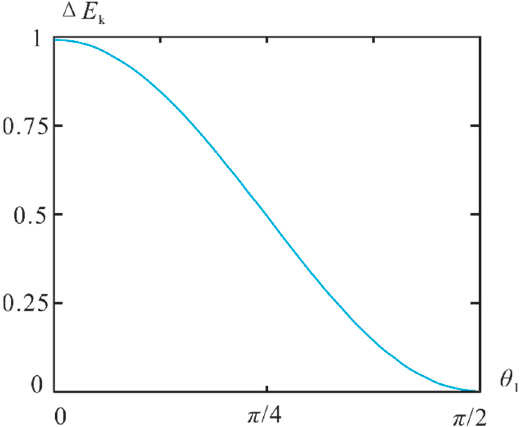
Figure 7. The change of the trunk work with the robot trunk angle.